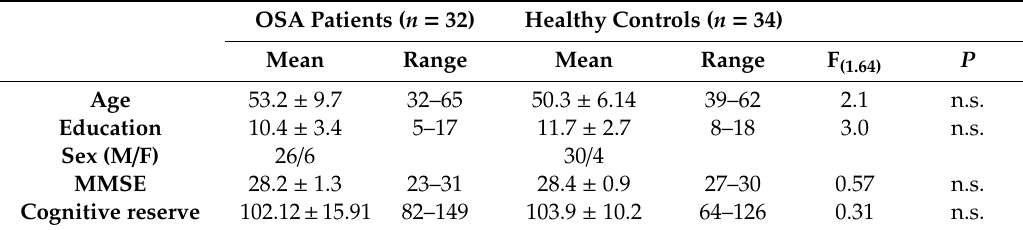
Table 1. Demographic and clinical data of obstructive sleep apnea (OSA) patients and healthy controls.